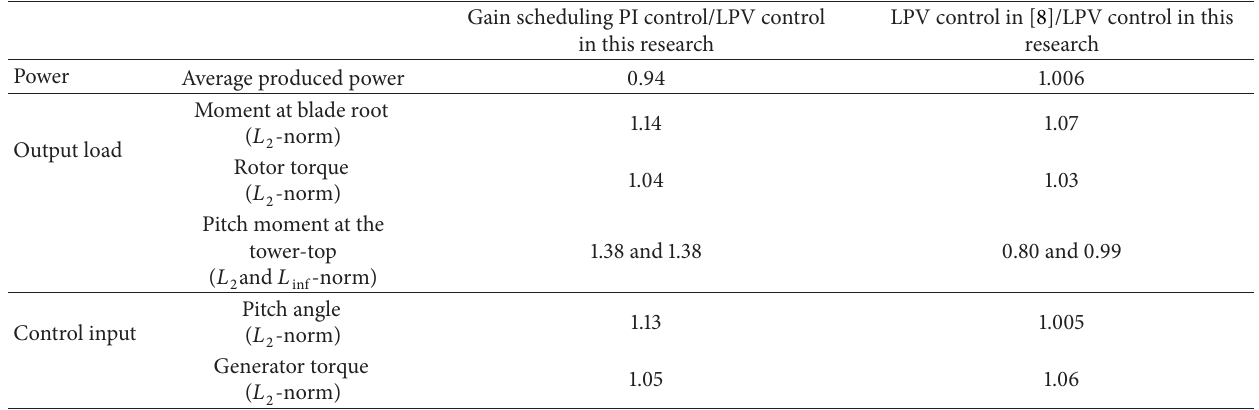
Table 3: Comparison of the simulation results from the three control schemes.